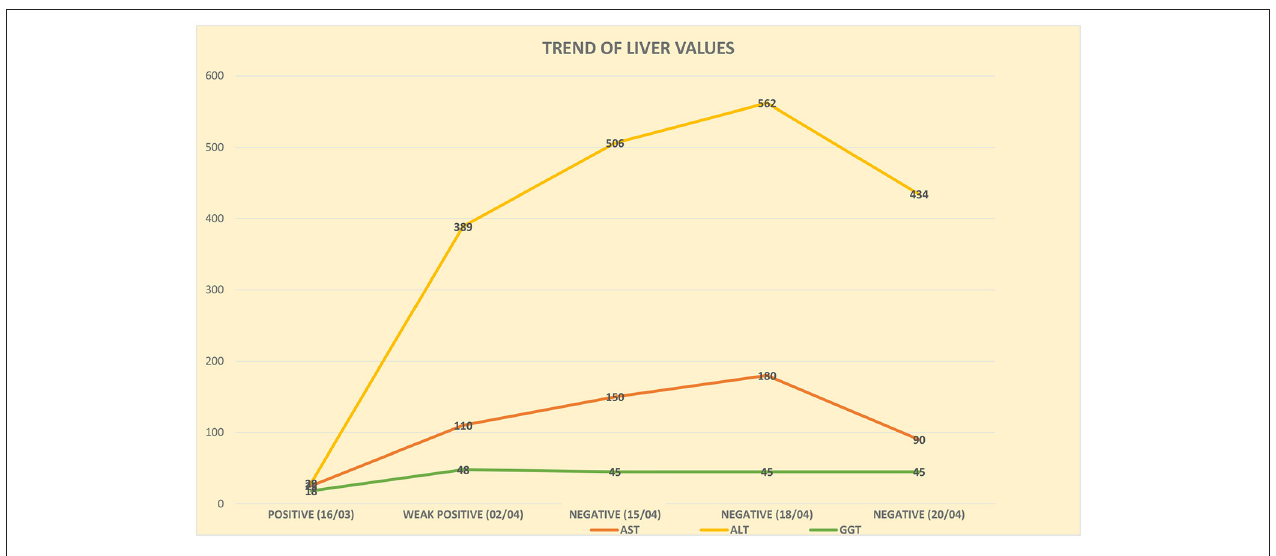
FIGURE 1 | Trend of liver